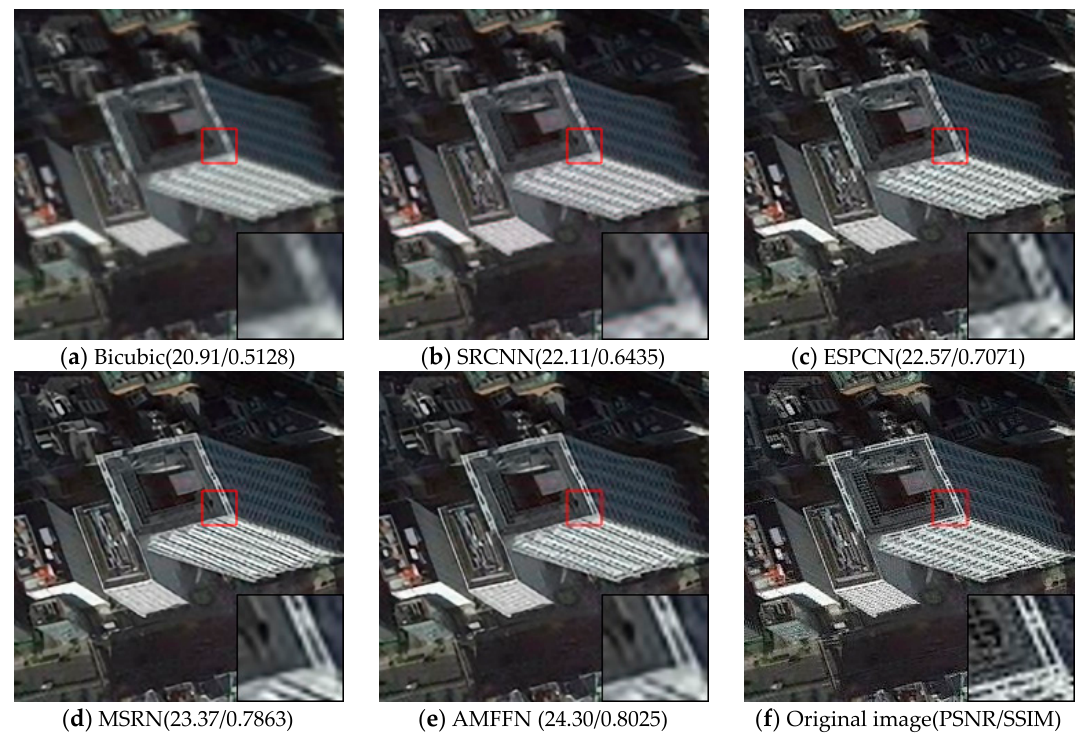
Figure 10. Results of building scenes in NW dataset of different methods with scale factor ×2.